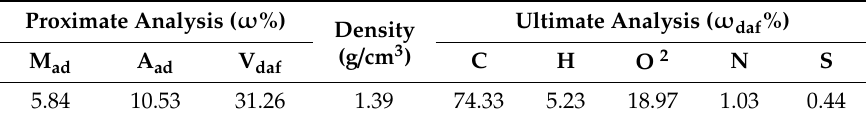
Table 1. Conventional analysis of the Bulianta coal sample 1 .